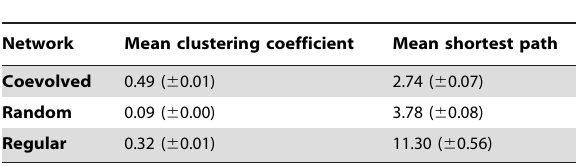
Figure 1. ‘Small-world’ characteristics of coevolved networks. Shortest paths and clustering coefficients are calculated and plotted for each family/network that has average degree (k) equal or more than 2. doi:10.1371/journal.pone.0008591.g001 charge compensatory substitution quads for each pair of coevolved alignment columns. Figure 4 shows the fraction of various charge substitution quads within the coevolved sites with respect to their spatial distances. We observed that , 80% of charge compensatory substitutions are found at very close spatial proximity of less than 5A˚ . It indicates that these substitutions might be maintained in evolution to preserve the salt bridges. Similarly, we also found that the spatial distance distribution of charge compensatory substitu- tions is significantly different (p-value % 0.01) than that of non- coevolved columns pairs (Figure S2). Table 1. Network